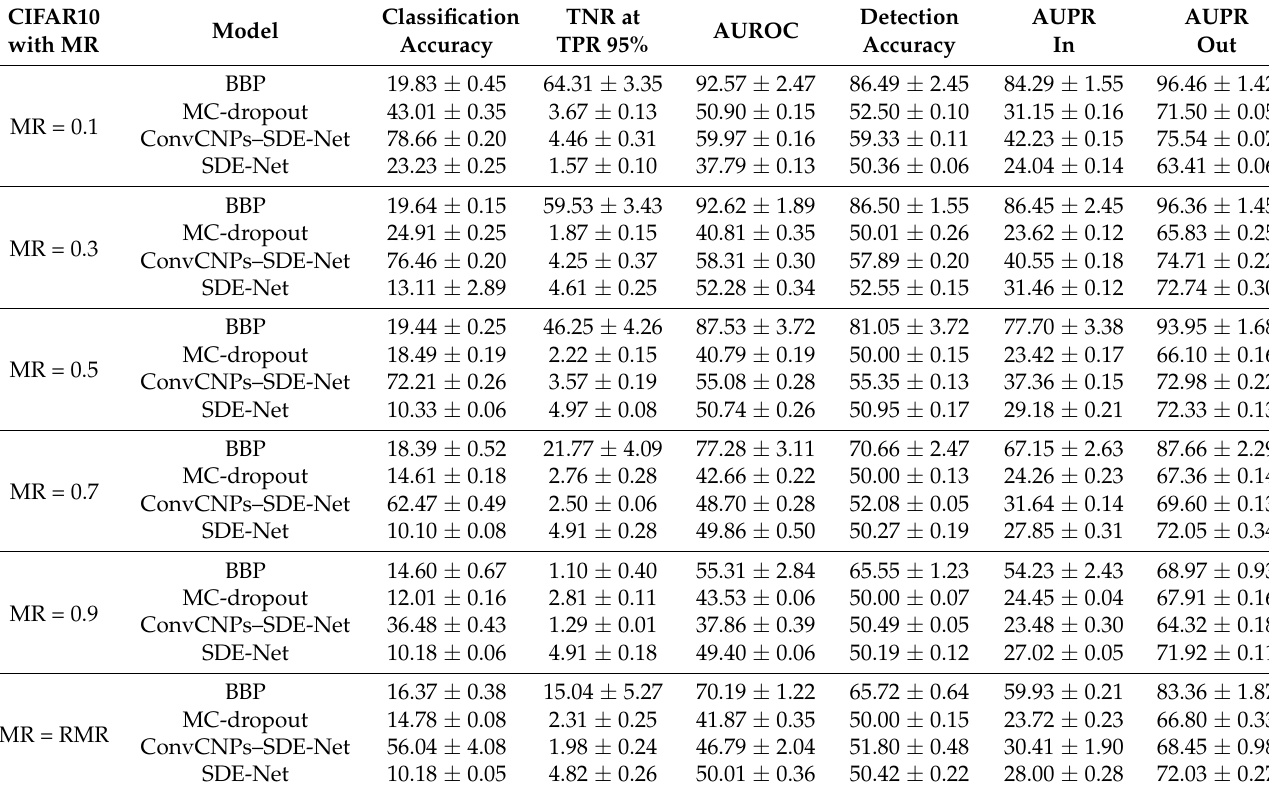
Table 5. Classification and OOD detection results of the BBP, MC-dropout, ConvCNPs–SDE, and SDE-Net models on ID